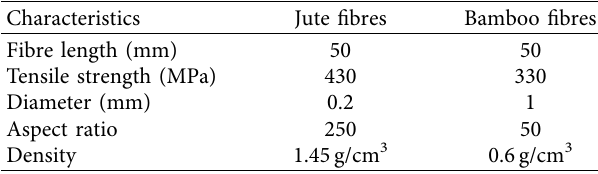
Table 1: Levels of variables. Table 2: Mechanical properties of